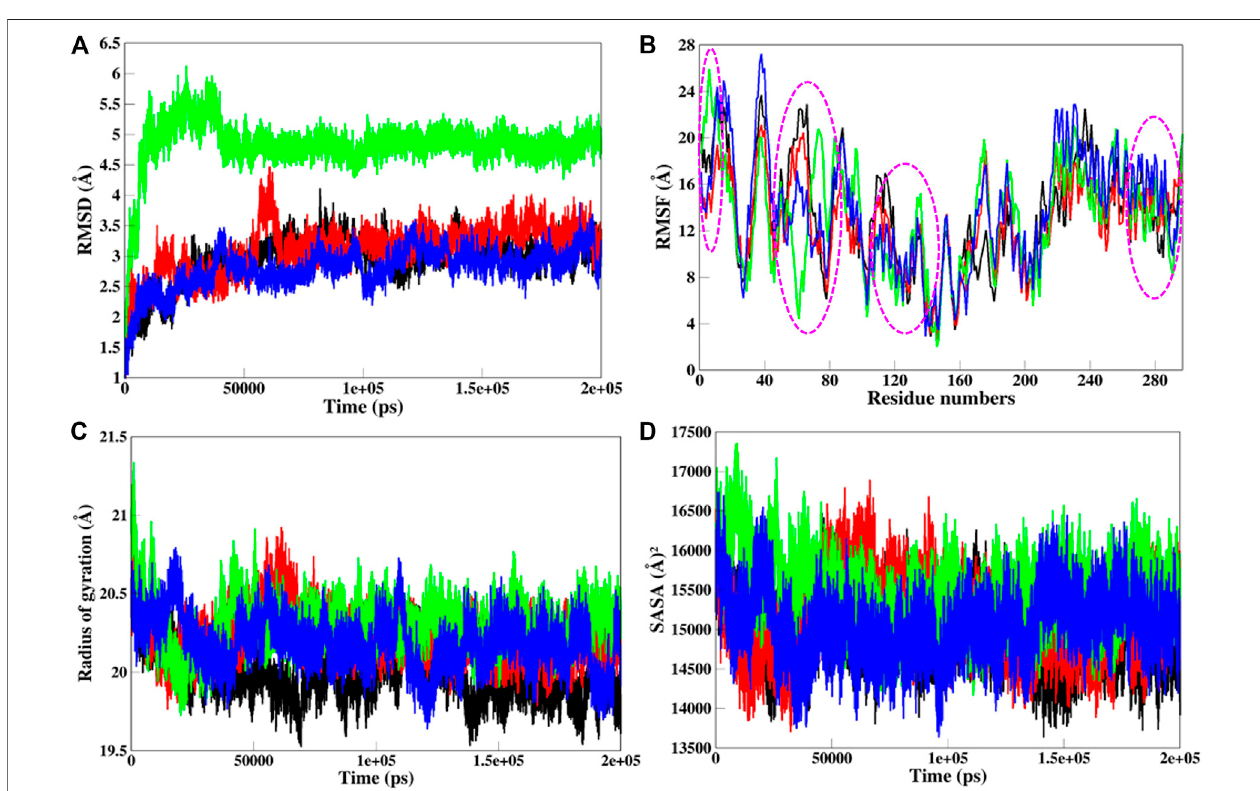
FIGURE 6 | Structural dynamics of SGK1 WT (red), K127M (black), T256A (green), and Y298A (blue) mutants (A) RMSD, (B) RMSF, (C) Rg, and (D) SASA values across C α backbone in Å of WT, K127M, T256A, and Y298A mutants calculated after 200 ns of MD trajectories.